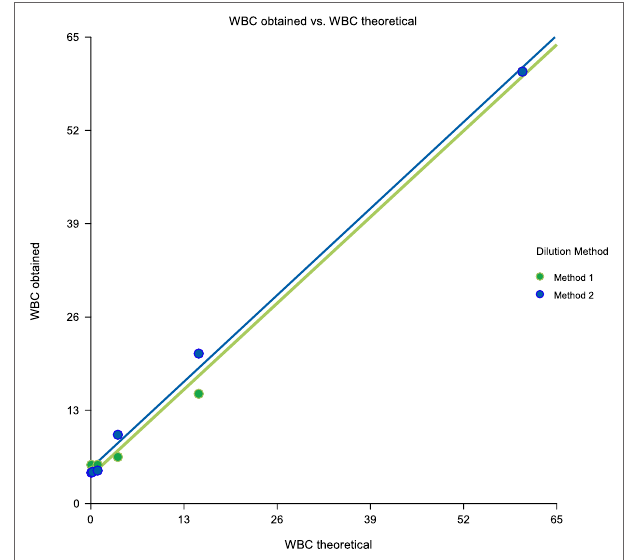
FIgURe 2 | Scatter diagram of obtained and theoretical white blood cell (WBC) in sample 2.